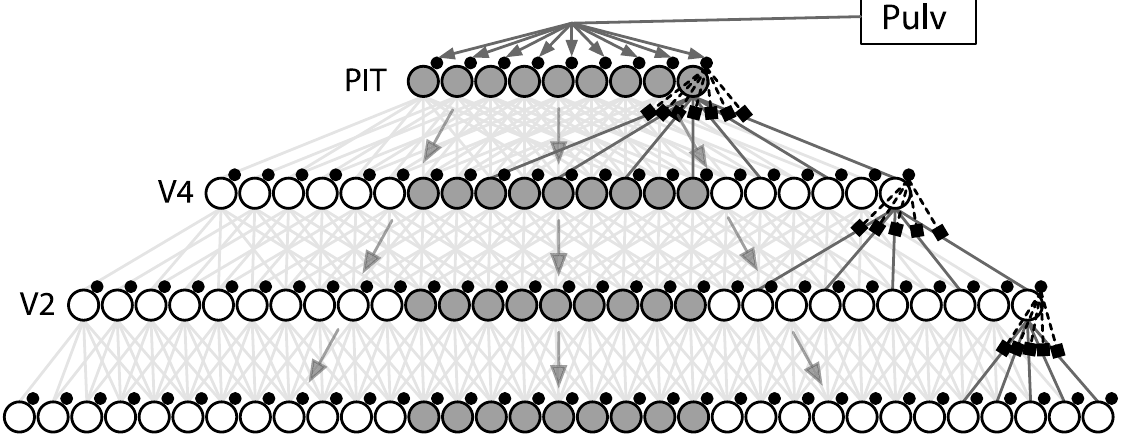
Figure 1. General architecture of the ARC. Each level has a columnar and retinotopic organization, where columns (large circles) are composed of visually responsive neurons (not individually depicted) and control neurons (small circles). Large filled circles indicate columns representing an example attentional target. Each column receives feedforward visual signals (gray lines) and a local attentional control signal from control neurons (dashed lines), and these signals interact nonlinearly in the terminal dendrites of pyramidal cells (square boxes). The application of this architecture to ventral stream processing is shown here. Global control signals from pulvinar are projected to PIT and then fed back to control neurons in lower levels. Connectivity is highlighted for the rightmost columns only, although other columns in each level have similar